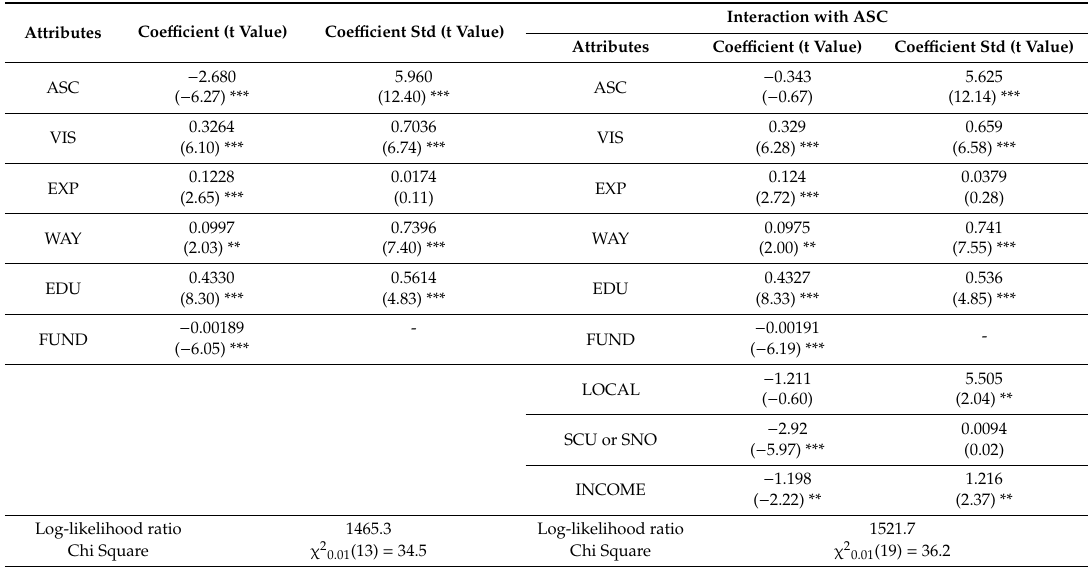
Table 2. Estimated results of the tourists’ preferences for the program of reef impact